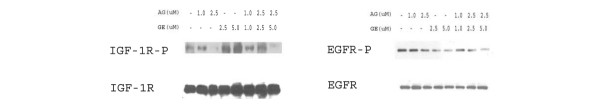
Single agent treatment effect on tyrosine phosphorylation (P; top) and protein expression of receptors. Western blot showing phosphorylation (P, top) and receptor protein levels (bottom). MCF-7 cells were used for detection of phosphorylation of the insulin like growth factor 1 receptor (IGF-1R) and MDA468 cells, for phosphorylation analysis of the epidermal growth factor receptor (EGFR). AG, AG1024; GE, gefitinib.